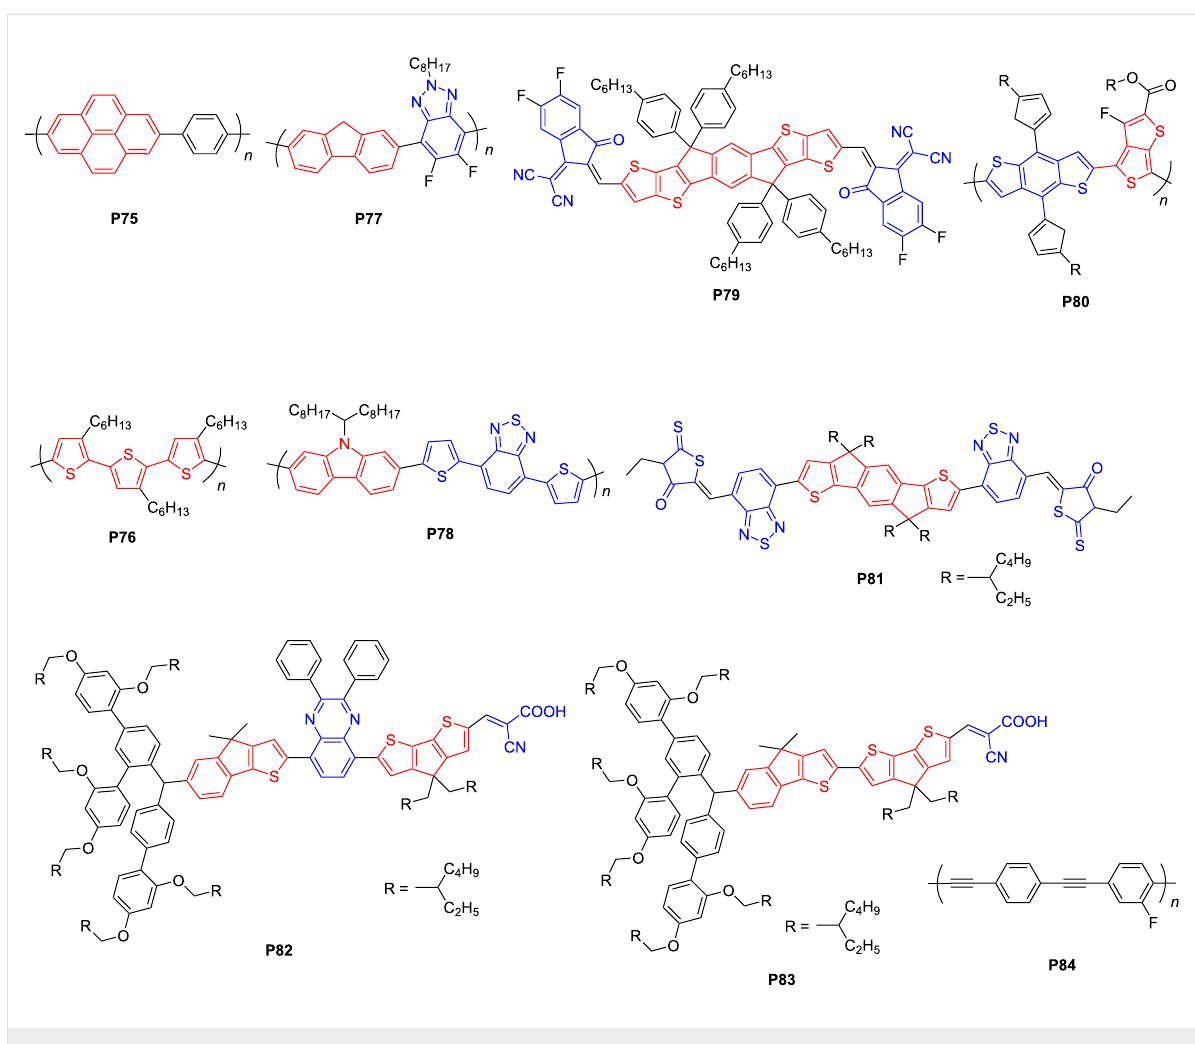
on ultrathin polyimide (PI) nanosheets, Zou et al. [102] achieved a HER of 30.65 μ mol h − 1 (50 mg) with 15%